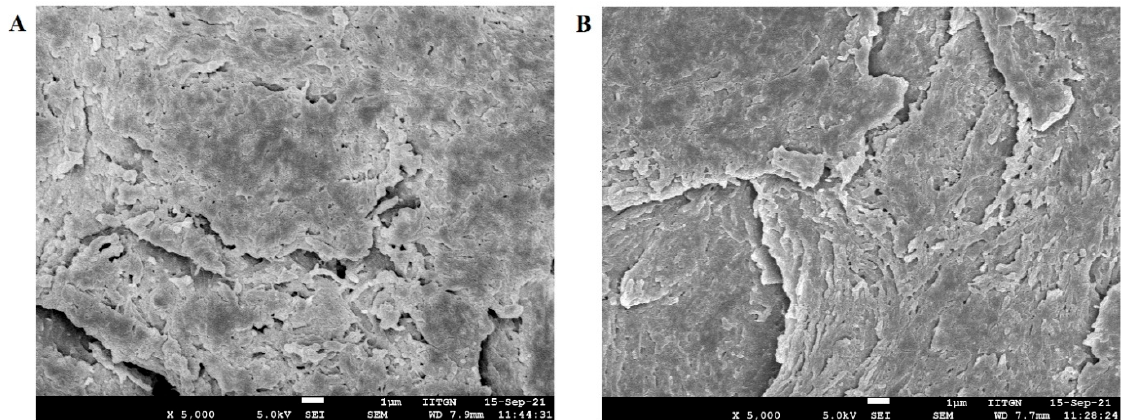
Figure 11. Scanning electron microscopy images of ( A ) treated nail plate (iontophoresis, 12 V for 6 h using formulation F8) and ( B ) control nail (passive, 0 V for 6 h using formulation F8).